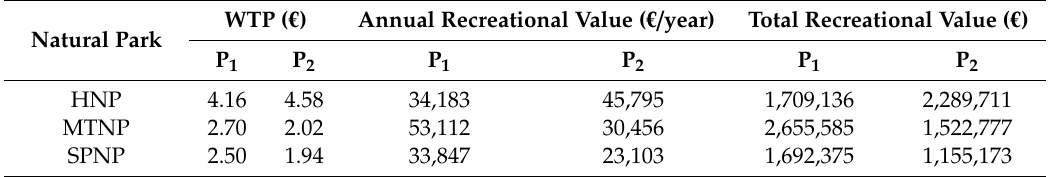
Table 15. Total Recreation Value ( € ) for Alicante´s province Natural Parks in both periods.